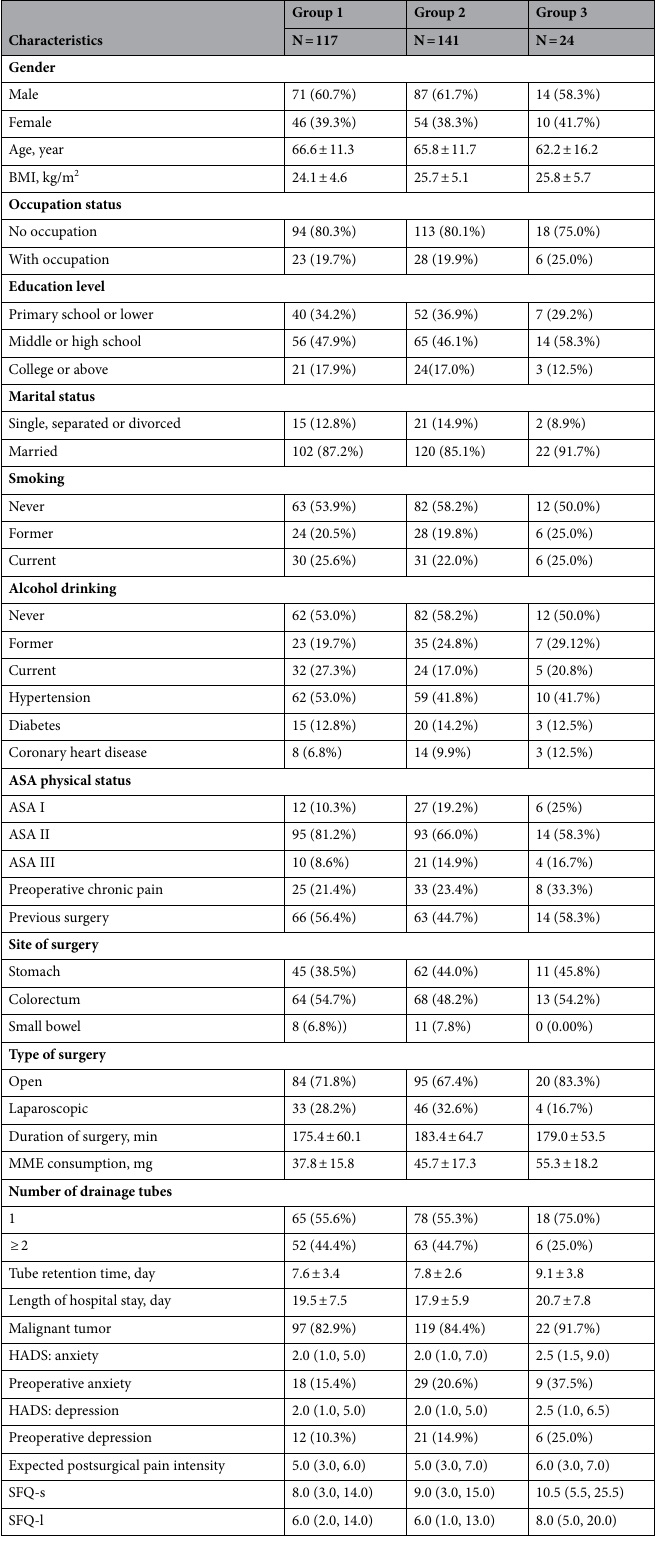
Table 1. Demographic, clinical and psychological characteristics between 3 trajectory groups. Data are presented as mean ± standard deviation, median (interquartile range), or number (percentage). BMI body mass index, ASA American Society of Anesthesiologists, MME morphine milligram equivalent, HADS Hospital Anxiety and Depression Scale, SFQ-s Surgical Fear Questionnaire short-time consequences, SFQ-l Surgical Fear Questionnaire long-time